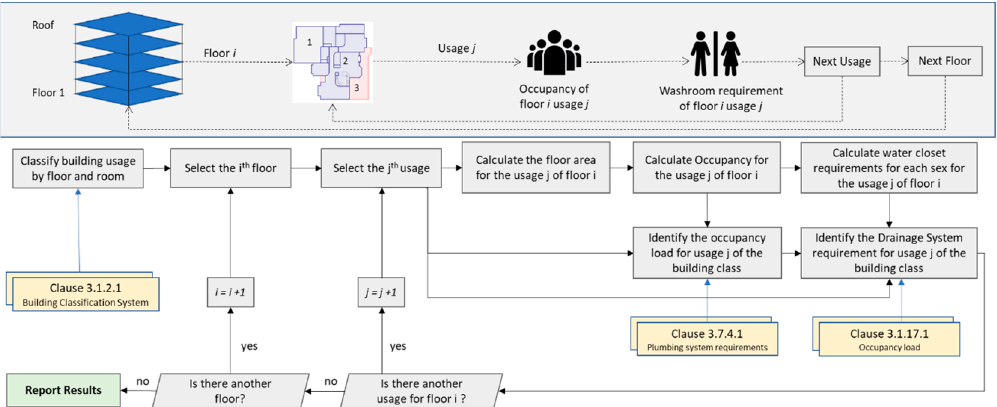
Figure 3. A general framework for how the rule should be checked.